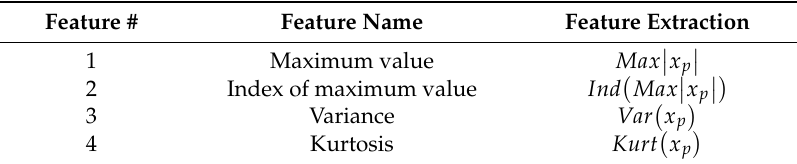
Table 3. Non-Contact Technique Features List